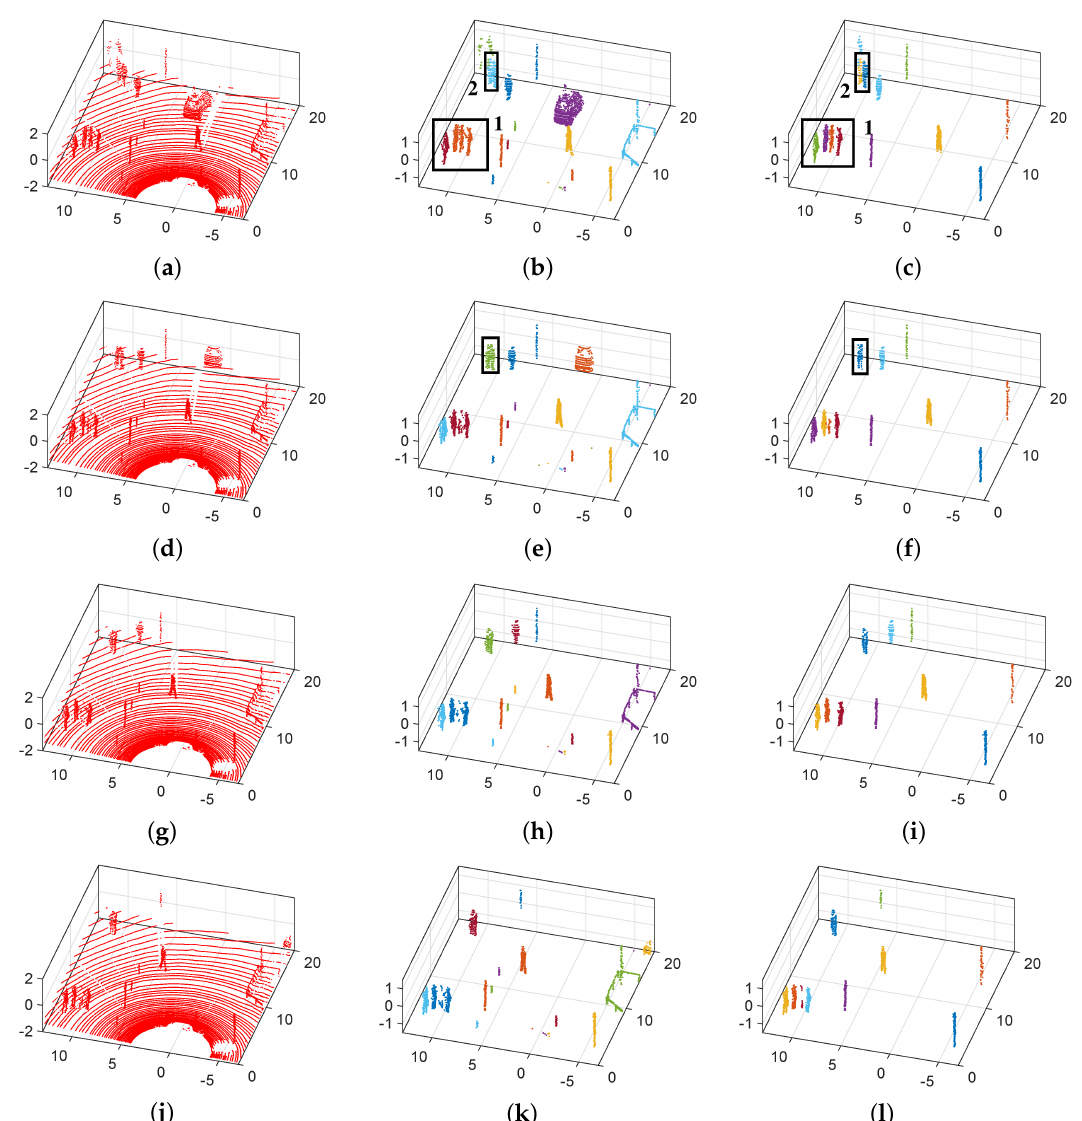
Figure 5. Clustering results. Images in the first column are the original point clouds. Results in the second column are clustering with radially bounded nearest neighbor (RBNN). The results in the third column are the clustering with kernel density estimation (KDE). ( a ) Original point clouds (Frame 1); ( b ) RBNN (Frame 1); ( c ) KDE (Frame 1); ( d ) original point clouds (Frame 11); ( e ) RBNN (Frame 11); ( f ) KDE (Frame 11); ( g ) original point clouds (Frame 21); ( h ) RBNN (Frame 21); ( i ) KDE (Frame 21); ( j ) original point clouds (Frame 31); ( k ) RBNN (Frame 31); ( l ) KDE (Frame